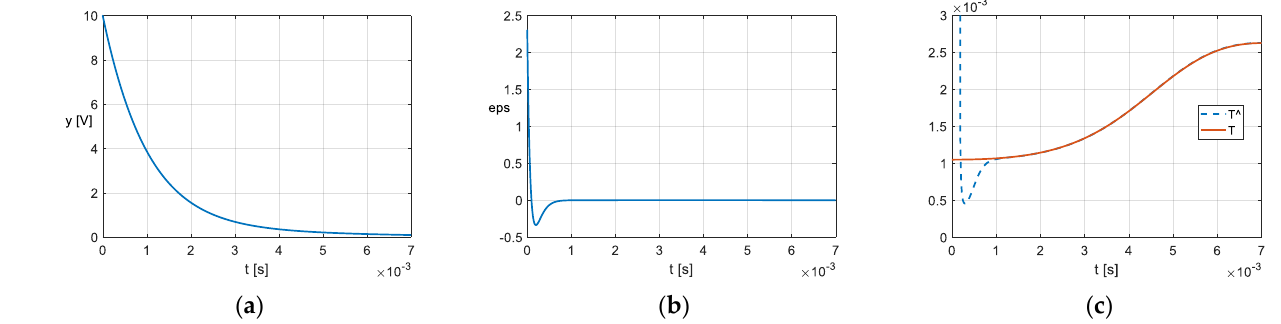
Figure 4. The behaviour of the PO for y ( t ) given by the Formula (19), ˆ z 0 = 0, ˆ c 0 = 0, τ = 10 − 3 s, ω 0 = 10 4 s − 1 , K p = 2 · 104 s − 1 , K i = 108 s − 2 : ( a ) input signal y ( t ); ( b ) error ε ( t ); ( c ) estimated ˆ T , and T calculated with (20).